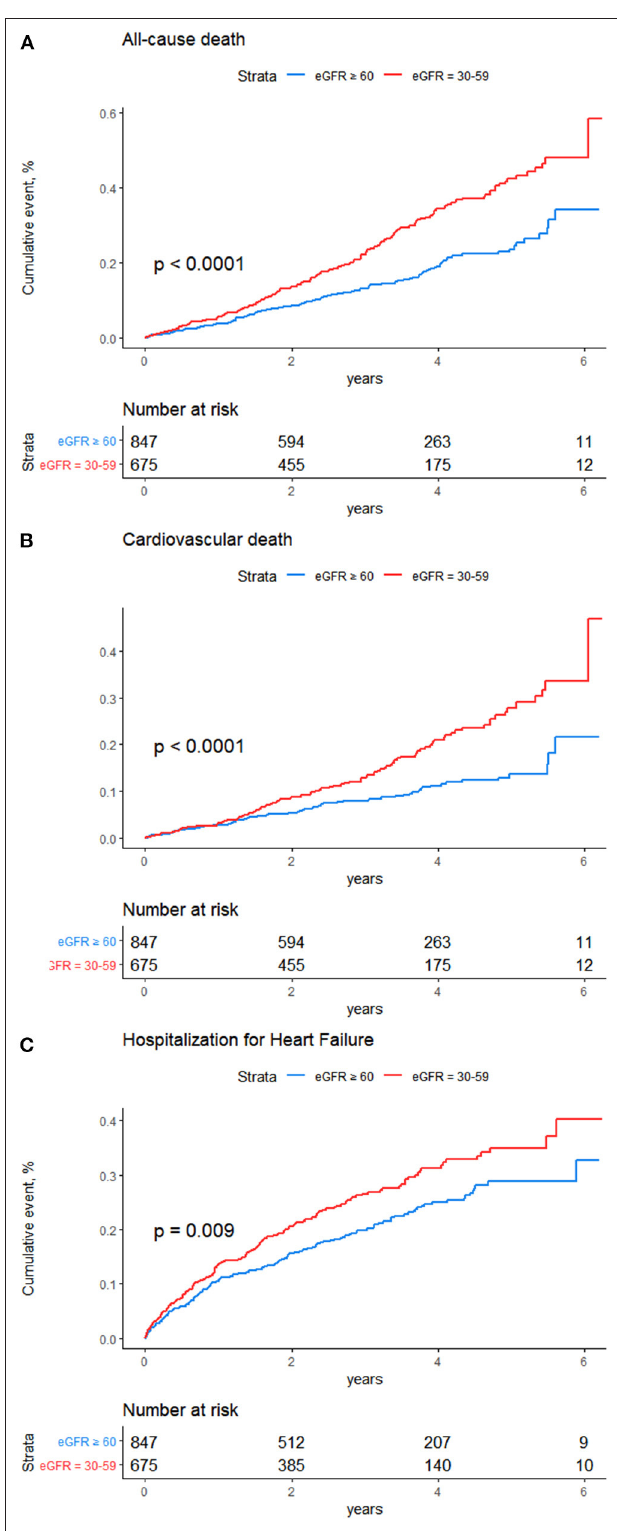
FIGURE 1 | Kaplan-Meier survival curves for events. Rates of (A) all-cause mortality, (B) cardiovascular death, (C) Hospitalization for heart failure.